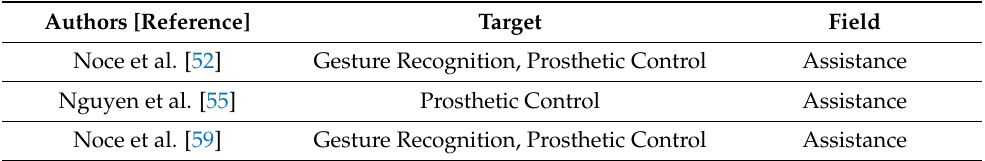
Table 4. ENG-based